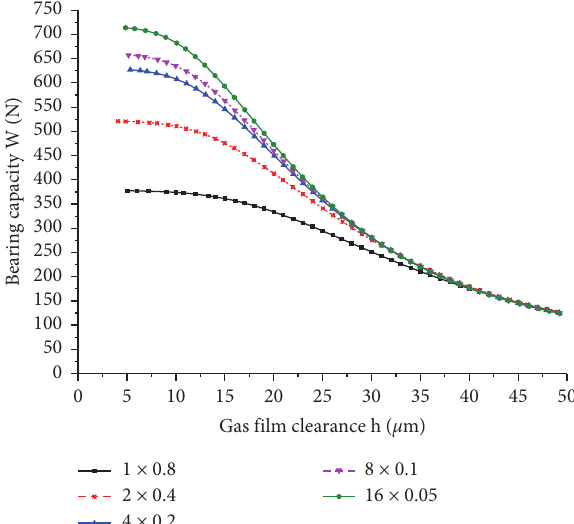
10: Curve of influence of the same throttled area on the bearing capacity.